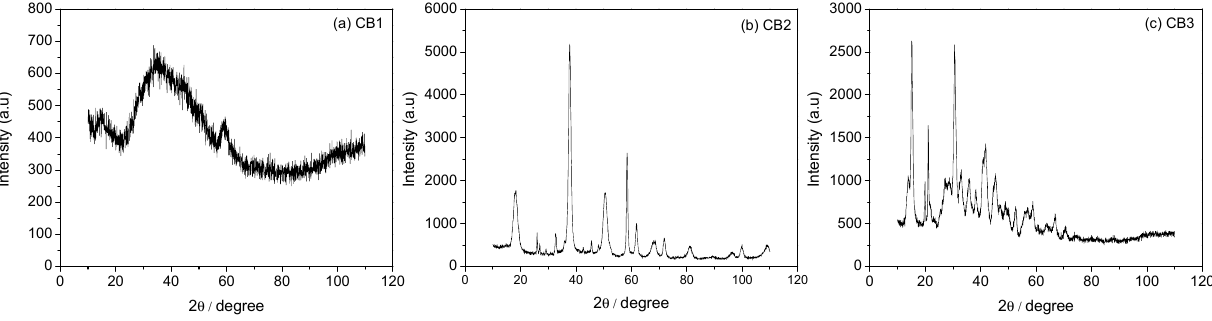
Figure 8. XRD patterns of ( a ) CB1, ( b ) CB2, and ( c ) CB3 products under atmospheric pressure.